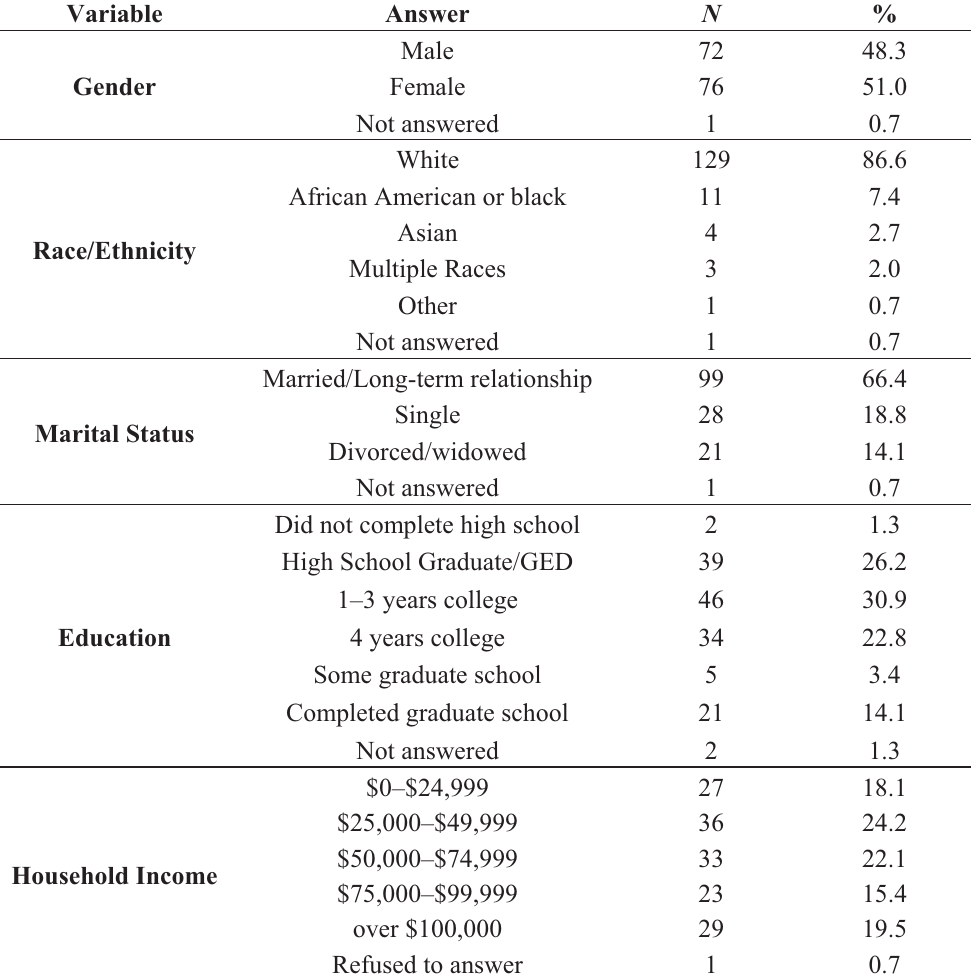
Table 1. Demographics of normal population subjects included in this study.